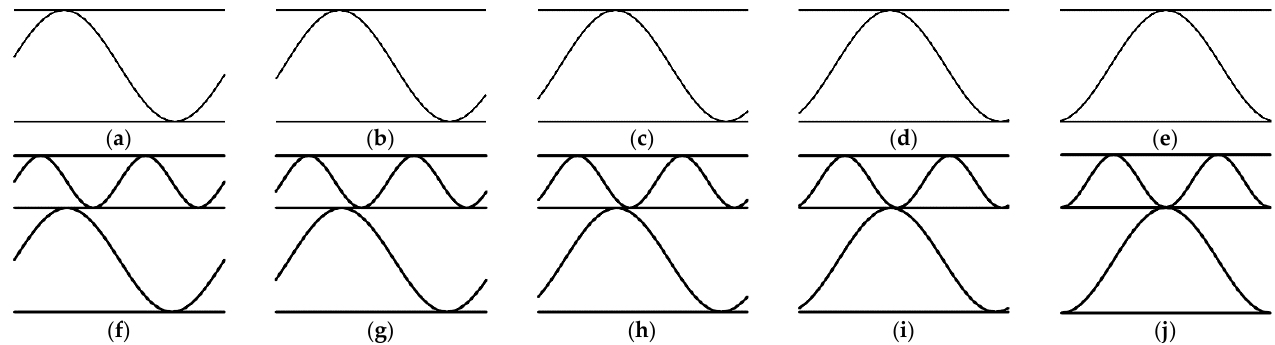
Figure 8. Crushed samples: ( a − c ) Single-walled sample crushed by 10%, 20%, and 30%, respectively; ( d − f ) Double-walled sample crushed by 10%, 20%, and 30%, respectively.